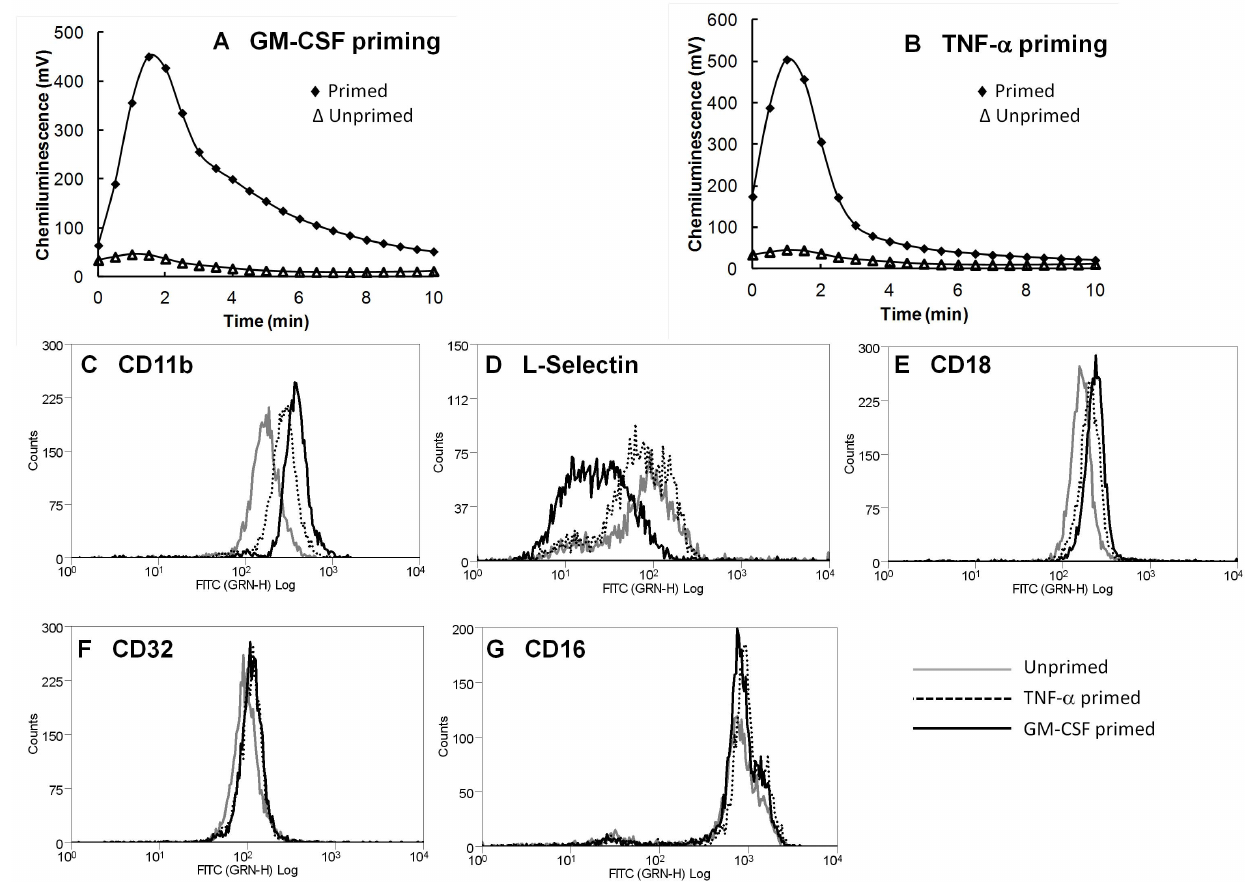
Figure 1. Effect of GM-CSF and TNF- a on neutrophil priming. (A,B) Neutrophils were primed with (A) GM-CSF (5 ng/mL) or (B) TNF- a (10 ng/ mL), and the respiratory burst was stimulated by fMLP (10 m M). A rapid respiratory burst was observed in primed cells ( ¤ ) but not in unprimed cells ( D ). (C–G) Flow cytometry analysis of adhesion molecule expression following priming with GM-CSF (black line) or TNF- a (dashed line) compared to unprimed neutrophils (grey line). (C) CD11b and (E) CD18 expression was up-regulated following priming with both GM-CSF and TNF- a but showed a greater level of up-regulation after GM-CSF priming. (D) L-selectin showed significant shedding following priming with GM-CSF, but only moderate shedding after TNF- a priming. (F) Fc c RIIA (CD32) expression did not change following priming with either cytokine, and (G) Fc c RIIIB expression was maintained by priming with either cytokine compared to the level of expression in untreated neutrophils from which the receptor was shed during 1 h incubation.